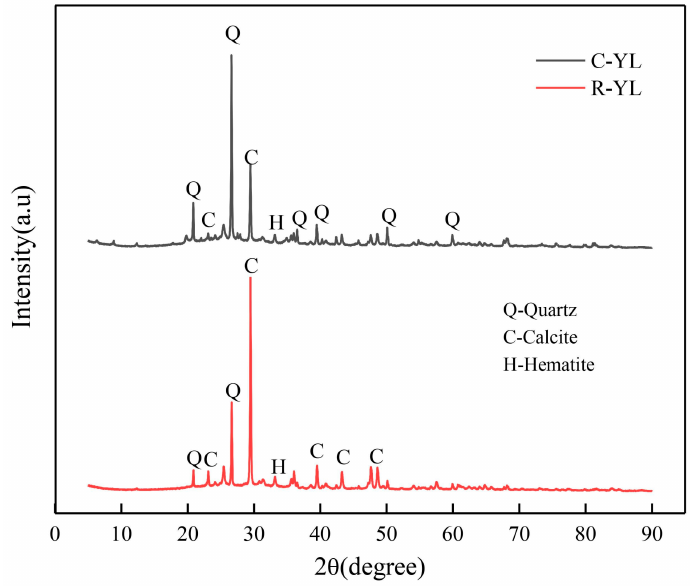
Figure 1. XRD analysis of R-YL and clean C-YL.